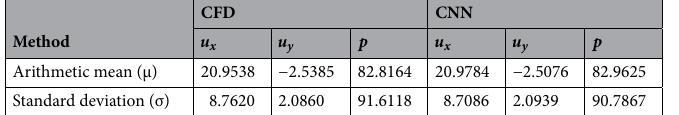
Table 3. Arithmetic mean and standard deviation of the results obtained by CFD and CNN.